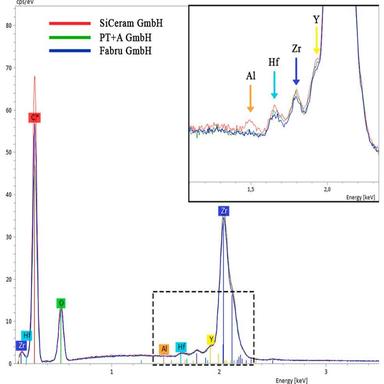
Elemental analysis of three commercial YSZ filaments obtained from energy dispersive X-ray spectroscopy at 10 kV.